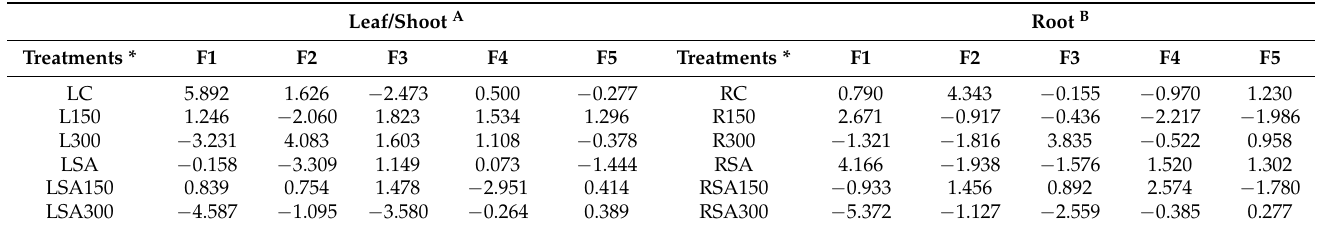
Table 4. Loadings of the factor scores ( p < 0.05) on principal components. A Leaf/shoot and B roots’ basic morphological and physiological parameters, cytokinin metabolites, IAA, BA, and JA measured in barley ( Hordeum vulgare L.) seedlings under salt and exogenous salicylic acid conditions. Leaf/Shoot A Root B